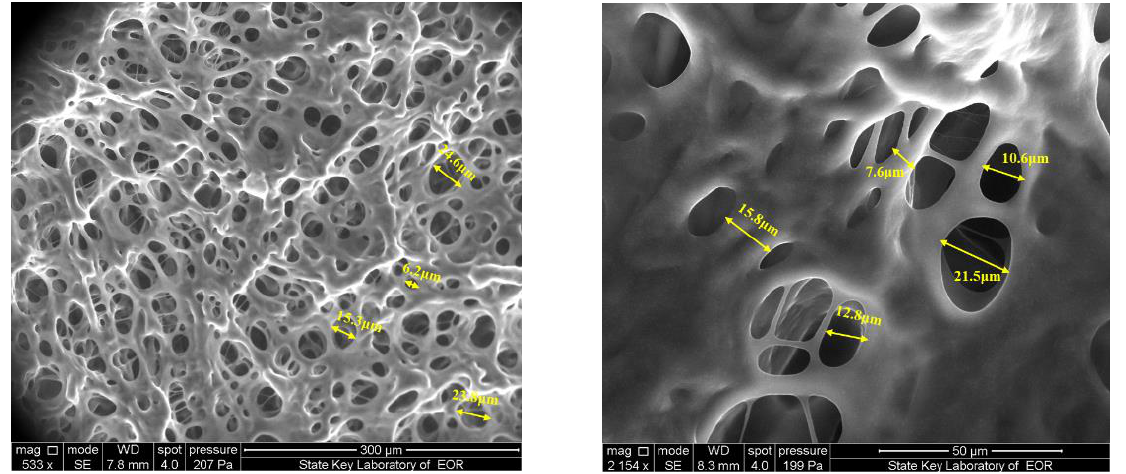
Figure 10. ESEM micrographs of the gel sample.